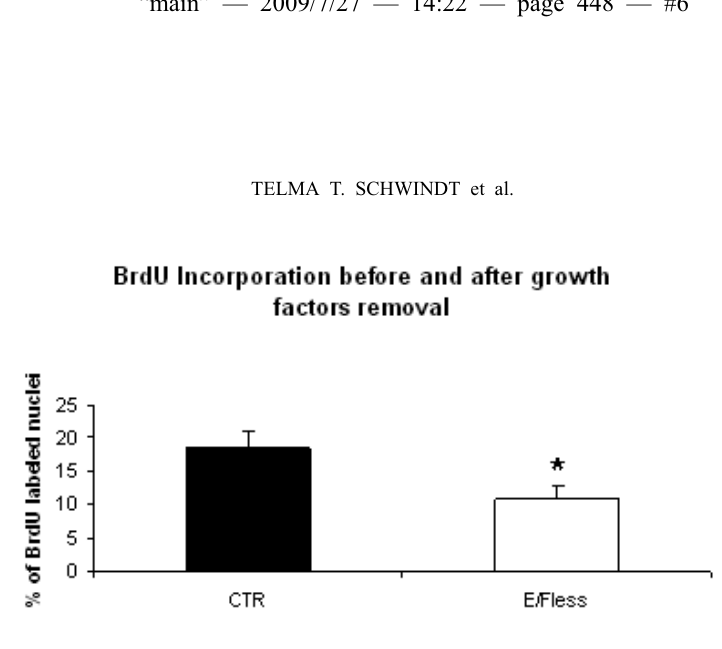
Fig. 1–ProliferationanalysisofmNPCbyBrdUincorporationaftergrowthfactorremoval. ThedifferencesinthepercentageofBrdUpositivecells between the CTR and the E/F-less groups after 11 days of growth factor withdrawal were statistically significant (n = 3; P < 0 . 05). Abbreviations: 11d – duration of treatment; CTR – neurospheres submitted to regular conditions; E/F-less – neurospheres grown in absence of FGF-2 and EGF.